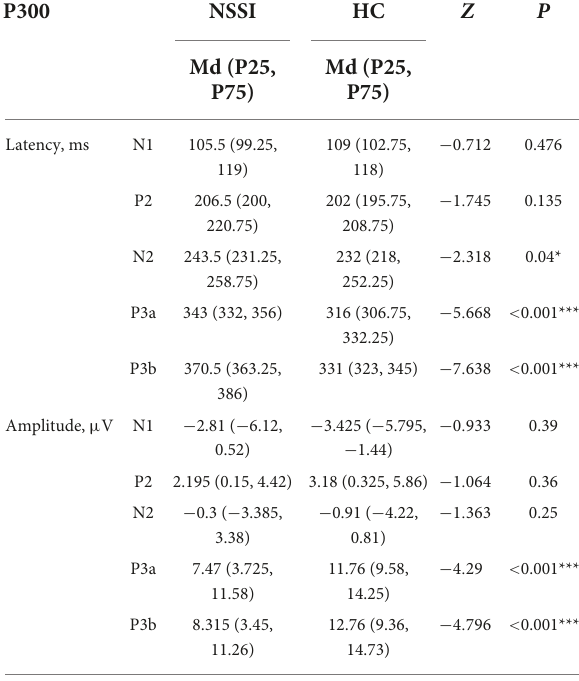
TABLE 2 P300 value between the NSSI and HC